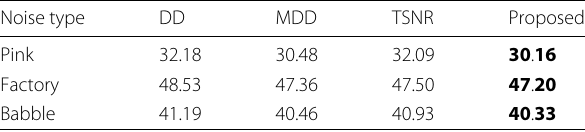
Table 3 Mean square error comparison of different a priori SNR estimation methods for different noise types